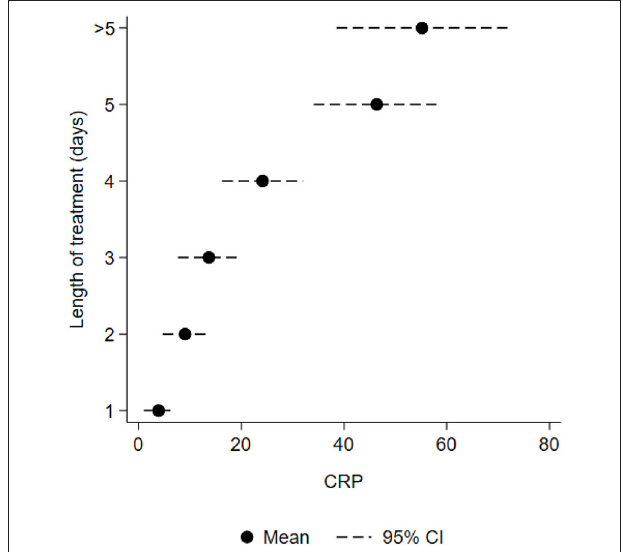
FIGURE 2 | Mean maximum CRP level ( n = 120) in relation to number of treatment days (GA ≥ 28 weeks) among Norwegian hospitalized